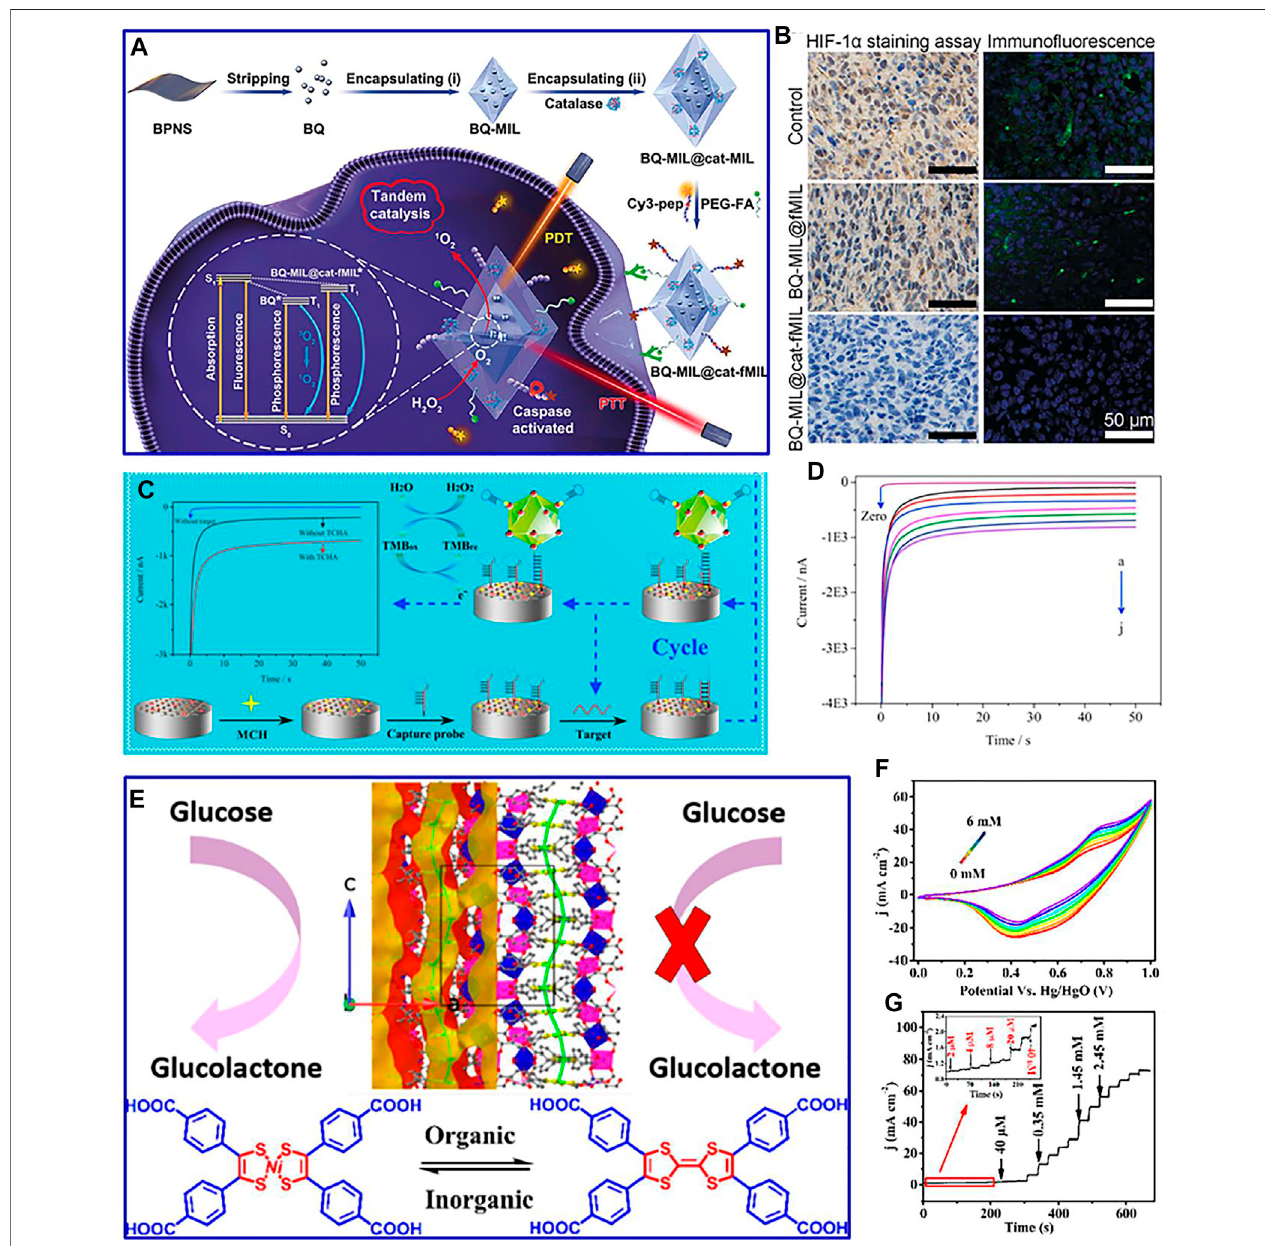
FIGURE 6 | (A) Assemble process of synthetic material and its mechanism against hypoxic tumor cells; (B) immunohistochemistry and immuno fl uorescence stainingofHIF-1 α intumor slices ofdifferentcomposites. Reproducedwithpermission (Liuet al.,2019).Copyright2019,Wiley. (C) Fabrication processofthebiosensor and the target-catalyzed hairpin assembly for target recycle; amperometric curves (D) of the proposed biosensor incubated with different concentrations of miR-122 containing 1 mM 3,3 ′ ,5,5 ′ -tetramethylbenzidine and 20 μ M H 2 O 2 . Reproduced with permission (Li et al., 2018). Copyright 2018, Elsevier. (E) Structures of the constructed material; CVcurves (F) and amperometricresponse (G) oftheconstructed material withvariedglucoseconcentrations.Reproduced withpermission (Zhou et al., 2020). Copyright 2020, ACS.